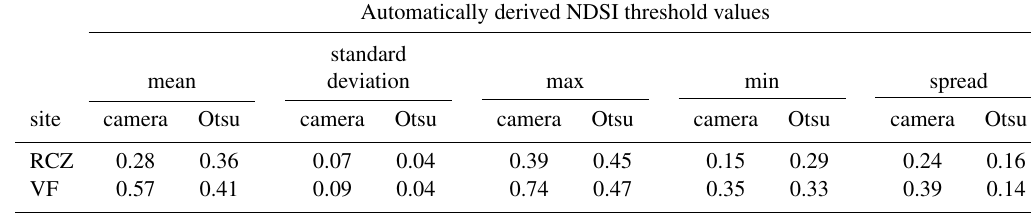
Table 1. Basic statistics of the automatically derived NDSI threshold time series at RCZ and VF using the Otsu segmentation method and the camera-based calibration method.